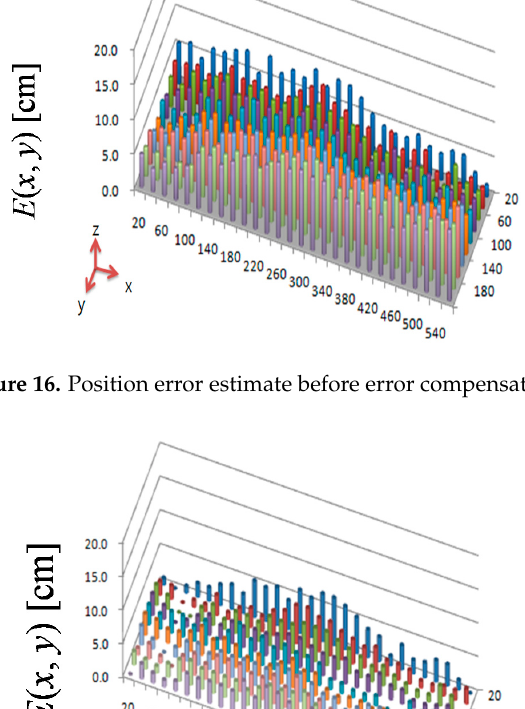
Figure 17. Position error estimate after error compensation.